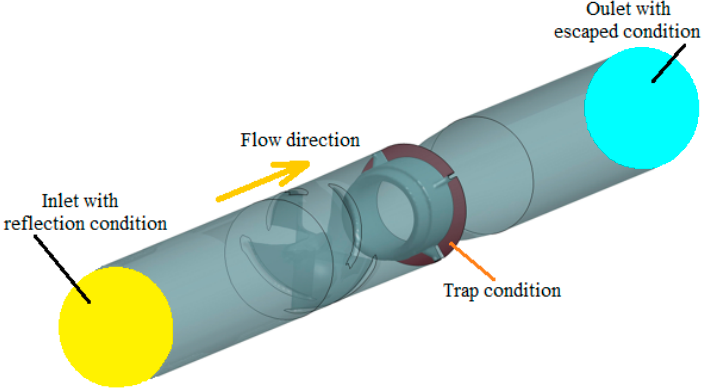
14 of 28 Figure 4. Axial flow cyclone model.